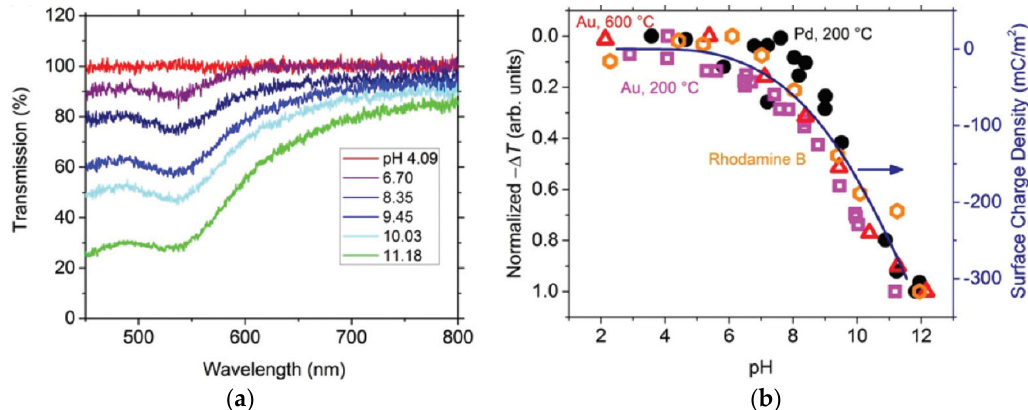
Figure 17. ( a ) Transmission spectra of optical fiber pH senor coated with localized surface plasmon resonance (LSPR) Au-nanoparticles incorporated SiO 2 layer at different pH; and ( b ) pH sensing results from silica-matrix coatings embedded with a variety of optically active materials. (Reproduced from Reference [107] with permission from The Royal Society of Chemistry).